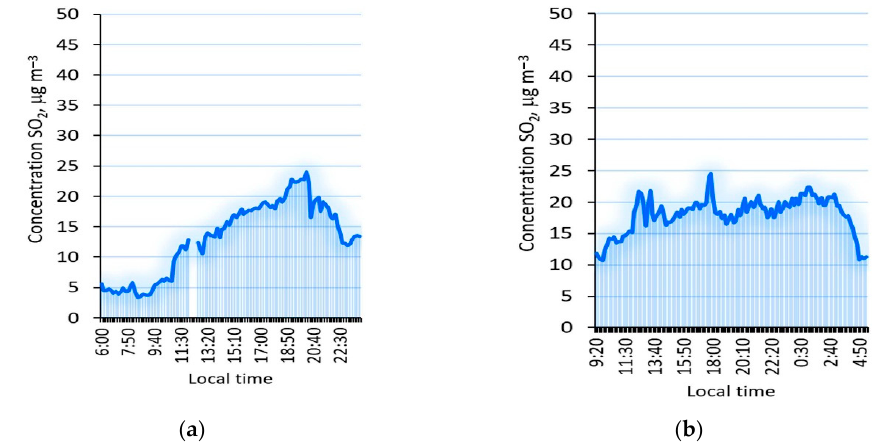
Figure 9. Temporal variation of sulfur dioxide concentration over the water area of Lake Baikal near settlements: ( a ) Turka (31 July 2019); ( b ) Kharauz (1–2 August 2019).